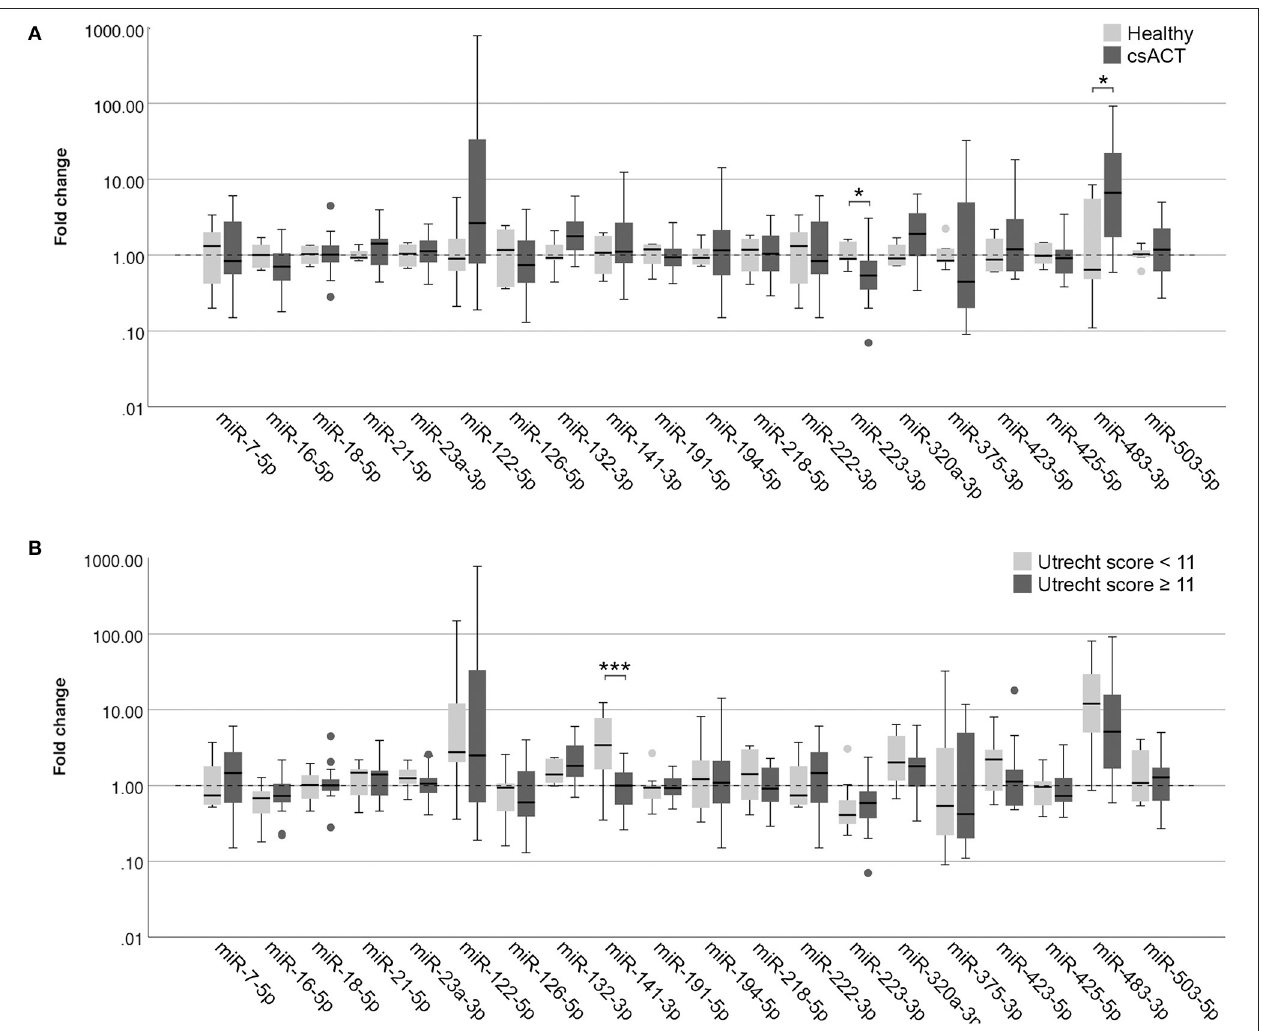
FIGURE 4 | Circulating miRNA expression levels in serum samples, normalized with V min (12 most stably expressed miRNAs), in (A) dogs with a csACT ( n = 26) and healthy dogs ( n = 6); and (B) dogs with a csACT with an Utrecht score below 11 ( n = 9) compared to those with a score of 11 or more ( n = 17). Circles above and below boxes indicate outliers. * p < 0.05; *** p < 0.001. csACT, cortisol-secreting adrenocortical